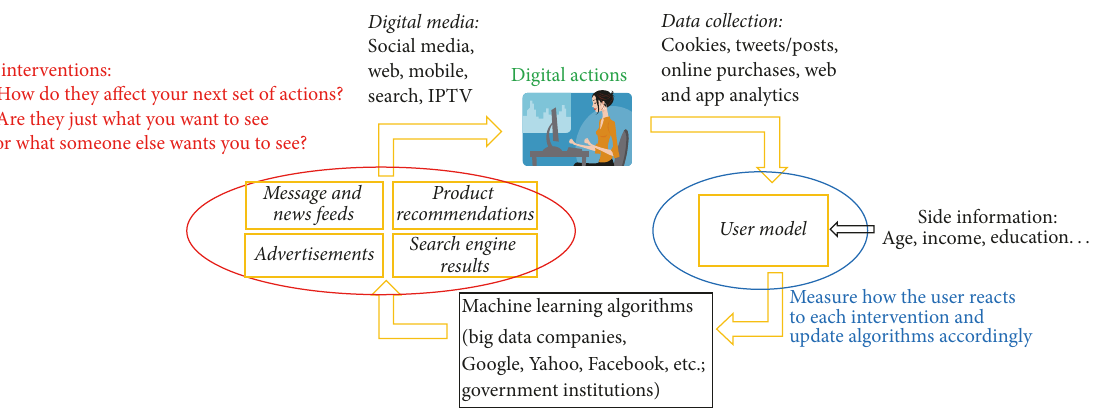
Figure 1: The Digital Feedback